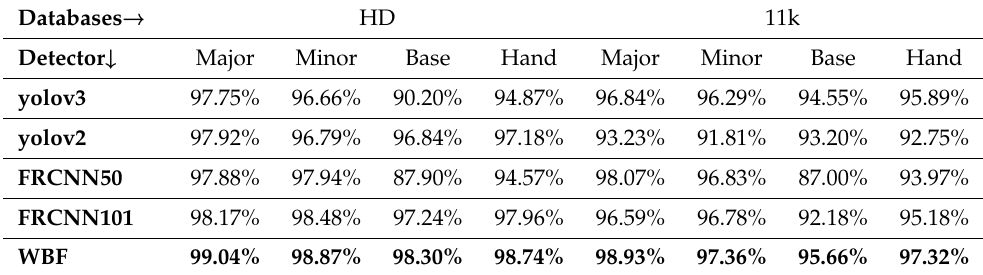
Table 9. Comparison of mean-AUC for the public